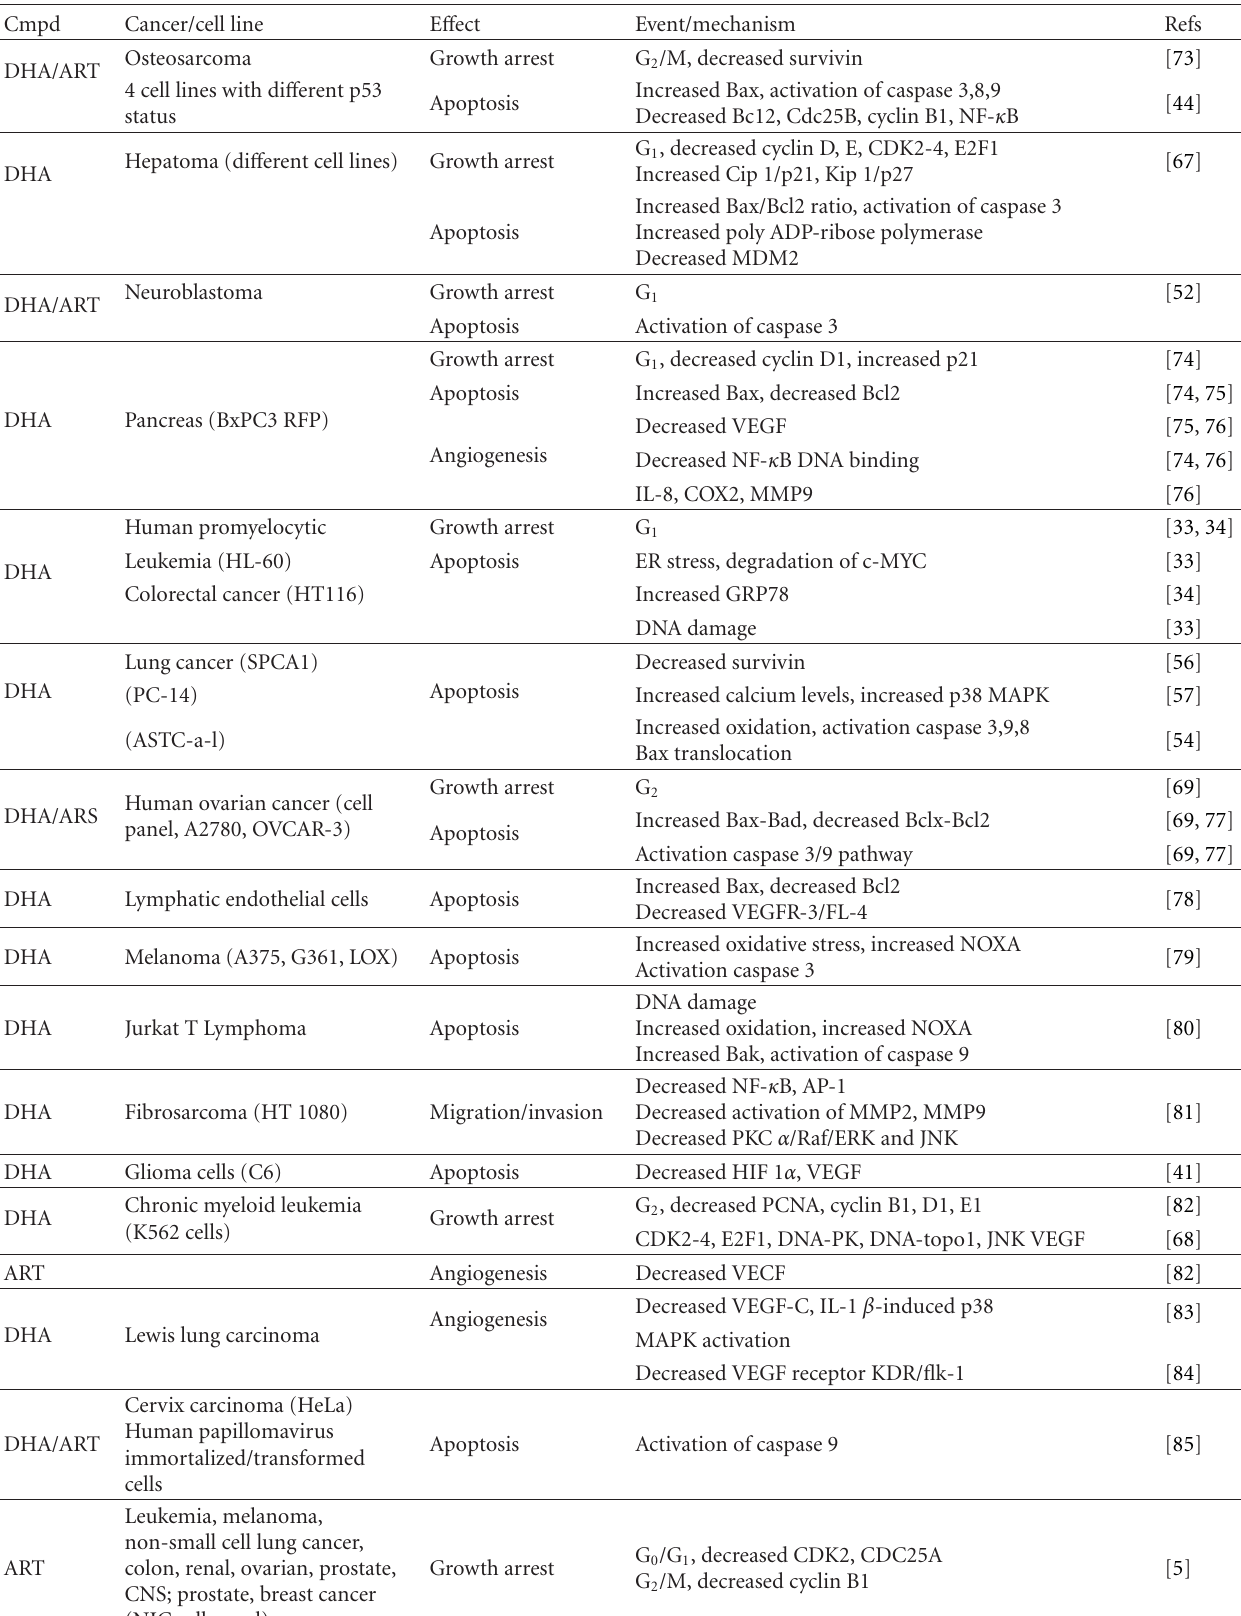
Table 2: Antitumor e ff ects of